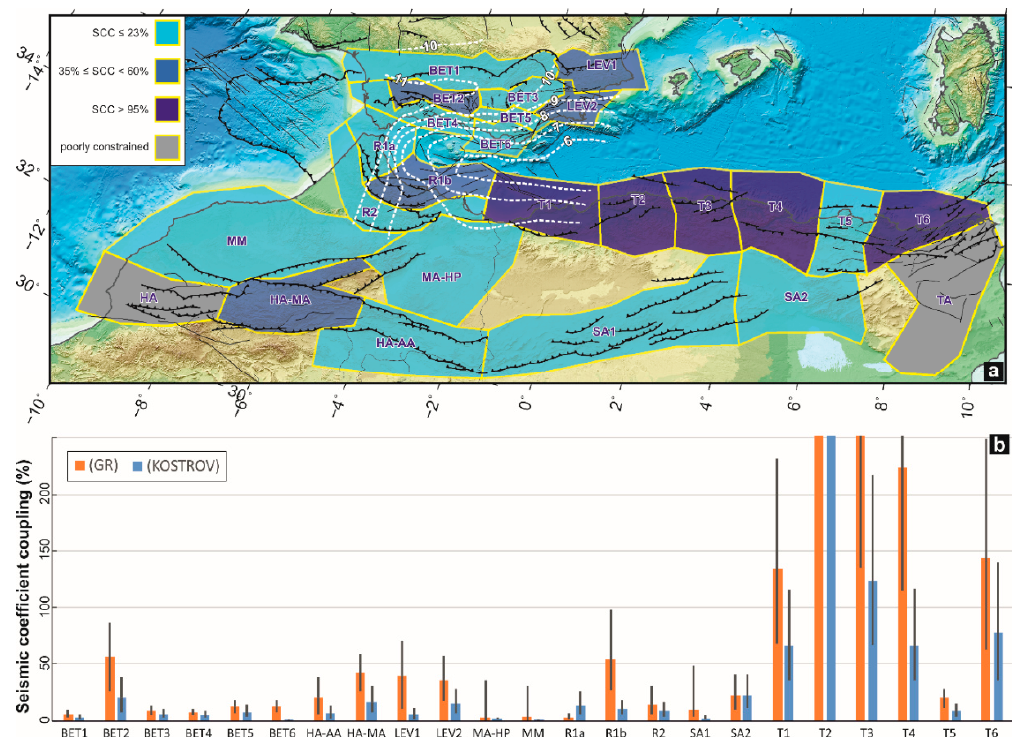
Figure 5. ( a ) Seismic coupling coefficient (SCC), expressed as a percentage of the seismic/geodetic moment-rate ratio as computed in this study (see SCC (*) values in Table 3). As discussed in the main text, three principal ranges of SCC values have been identified: low (less than 23%), intermediate (between 35% and 60%) and high (more than 95%). In grey are reported the SSZ excluded from the comparison, i.e., HA and TA (see the text for more details). The white dashed line represents the depth (in km) of the brittle-ductile transition as reported in [85]. ( b ) Comparison of the seismic coupling coe ffi cient (expressed as a percentage) which takes into account the moment-rates estimated from both the approaches discussed in the text. Confidence intervals (67%) are also